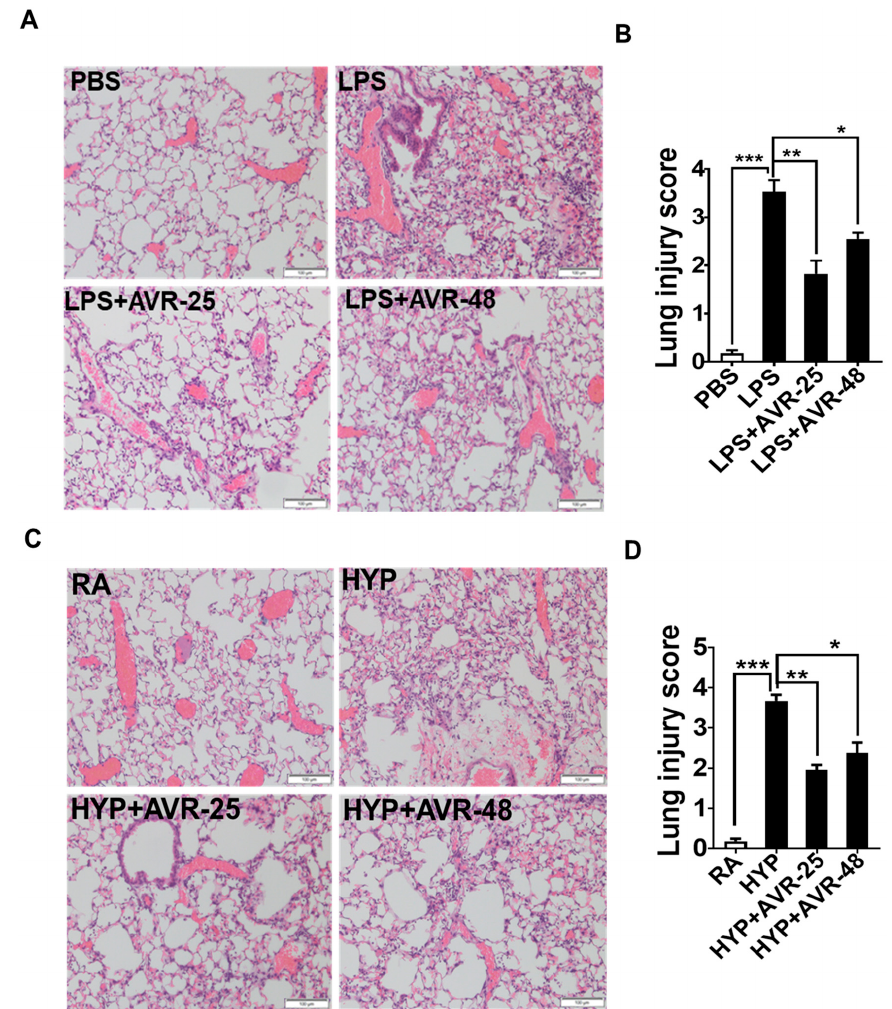
Figure 6. AVR-25 or AVR-48 treatment attenuated pulmonary injury in LPS- and hyperoxia-induced ALI mice. ( A , C ) Representative image of hematoxylin and eosin (H/E)-stained lungs of LPS- and hyperoxia-induced lung injury in mice receiving either AVR-25 or AVR-48 treatment or non-treatment ( n = 4-5 in each group). Scale bar = 100µm. ( B , D ) Lung injury score in LPS- and hyperoxia-induced lung injury in mice receiving AVR-25 or AVR-48 treatment or non-treatment ( n = 4–5 in each group, * p < 0.05 ** p < 0.01 and *** p < 0.001). AVR-25 or AVR-48 treated ALI mice showed decreased lung injury score as demonstrated by diminished pulmonary hemorrhage, peri-vascular exudates, thickened alveolar septa, and airspace edema as compared to ALI mice without treatment. Data are expressed as mean ± SEM. For statistical analysis, student’s unpaired t -test and one-way analysis of variance (ANOVA) followed by Tukey post hoc analysis were used. LPS: lipopolysaccharide; ALI: acute lung injury; PBS: phosphate buffered saline; RA: room air; HYP: hyperoxia.